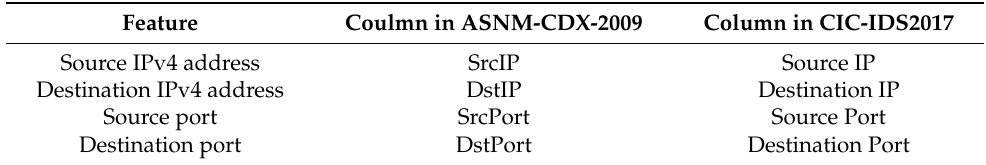
Table 2. Features from